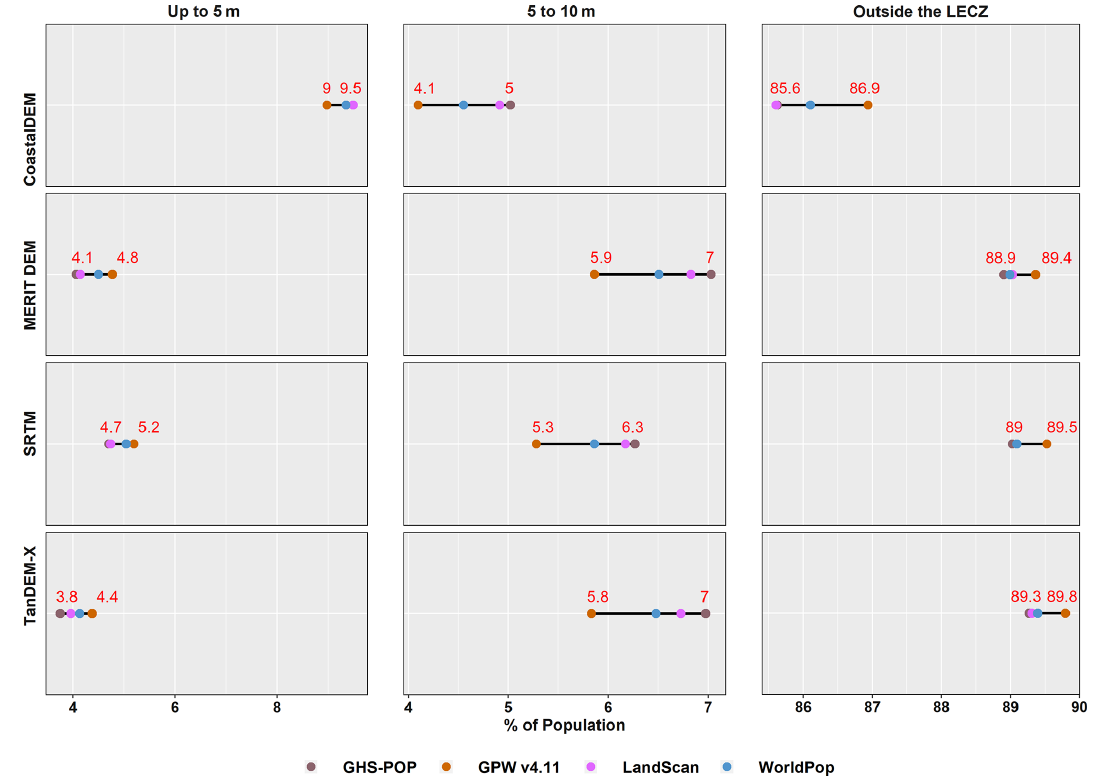
Figure 9. Estimates of population in different LECZs, by elevation and population data sources, 2015.